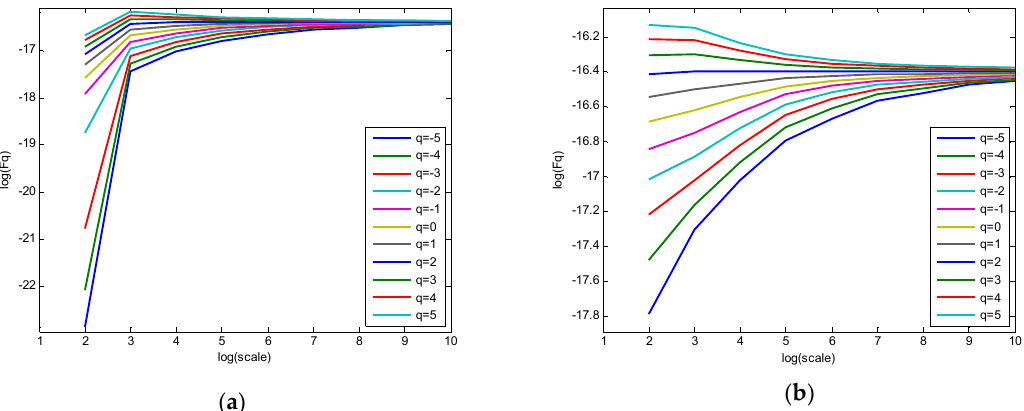
Figure 9. Double-log relation graph of low-frequency component d1 obtained using: ( a ) the traditional MFDFA algorithm; and ( b ) the new MFDFA algorithm.